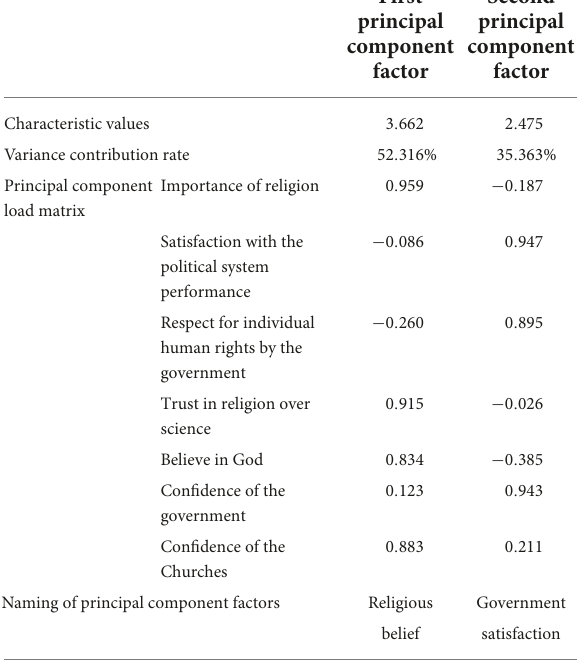
TABLE 1 Results of principal components analysis